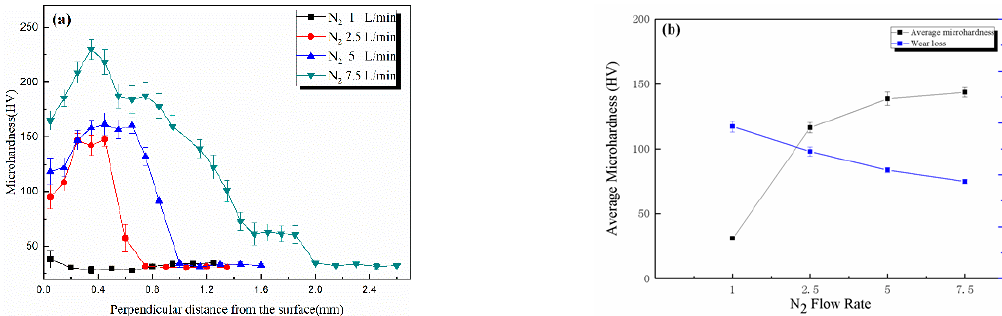
( d ) Figure 10. The macrostructures of nitrided layers prepared under N 2 flow rates of ( a ) 1 L/min, ( b ) 2.5 L/min, ( c ) 5 L/min, and ( d ) 7.5 L/min. As the pictures show, with the increase of N 2 flow rates from 1 L/min to 7.5 L/min, the scale of the nitrided layer is enhanced in thickness, from 100 µm to 1500 µm. The width of the molten pool also increases with the increase of N 2 flow rates. The widths of the molten pool corresponding to Figure 9a–d were 3 mm, 4 mm, 5 mm, and 6 mm respectively. As N 2 flow rate increases to 5 L/min, the whole nitrided layer will be too heavy to keep its initial shape and start to bend and sink into the molten pool. Compared with AlN-6082 prepared by a discharge current of 140 A, AlN-6082 prepared by a discharge current of 110 A has more considerable dendrite - like structures distributed from the bottom to the top. That is because the lower discharge current decreases the transport speed of the melt, which facilitate the formation of the dendrite-like structures. In addition, with the increase of N 2 flow rates, the dendrite-like structures grow more developed. The lamellae between adjacent dendrite-like structures are impacted closely. These developed dendrite - like structures and closely packed lamellae can increase the percentage of AlN phase, and improve the mechanical properties of the nitrided layer. The hardness characters and the wear losses of the nitrided layers are shown in Figure 11. Figure 11a demonstrates the microhardness curves of different layers. The strengthening layer is composed of the AlN phase and Al phase, so the hardness of the layer is determined by the distributions and characters of both phases, especially the ratios of the AlN phase to the total material. When N 2 flow rate is 1 L/min, the enhancement is not obvious due to the poor thickness of the nitrided layer. With the increase of N 2 flow rate, the average hardness of the layer is improved. When the N 2 flow rate is 7.5 L/min, the average hardness is nearly 7 times as that of the substrate. Excluding the curve of N 2 flow rate 1 L/min, these hardness curves bend upward in the middle, which means that the hardness